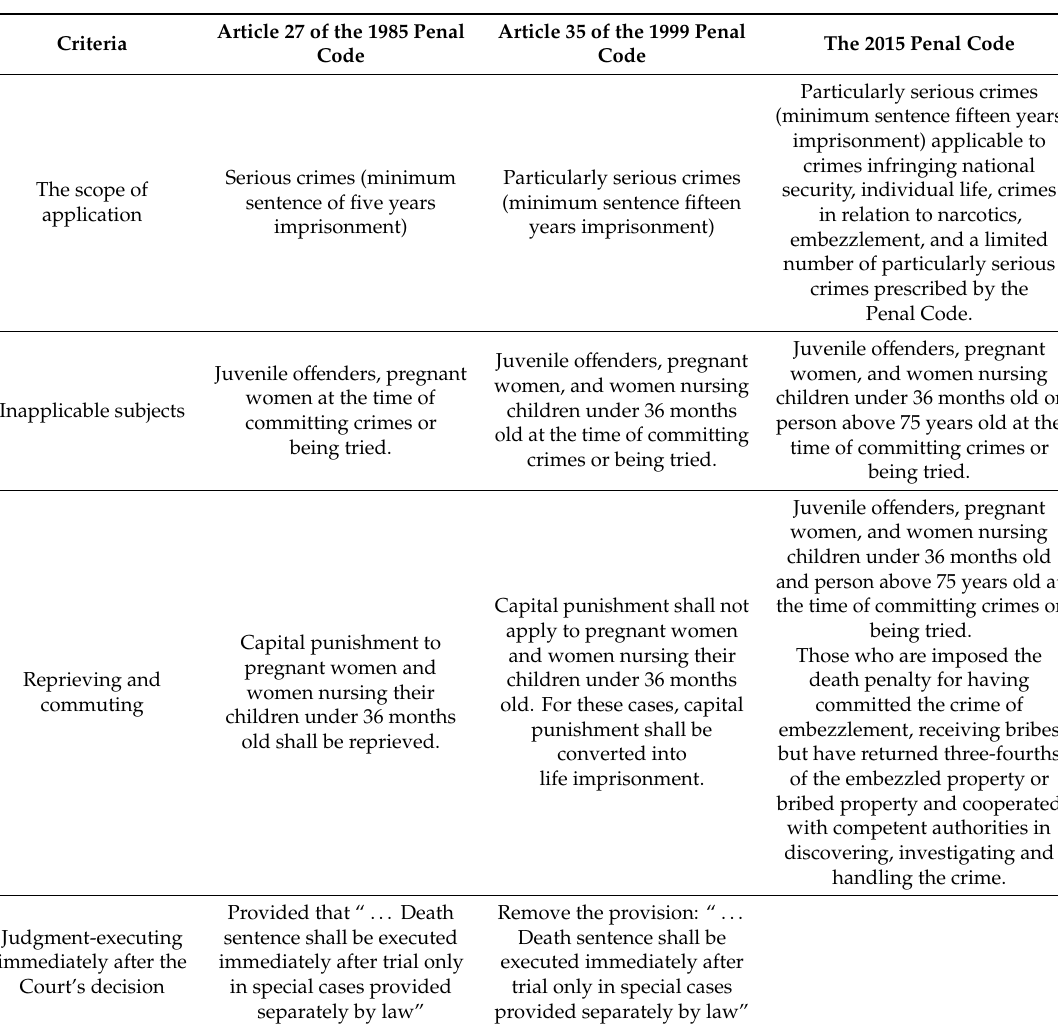
Table 2. Criteria for applying the death